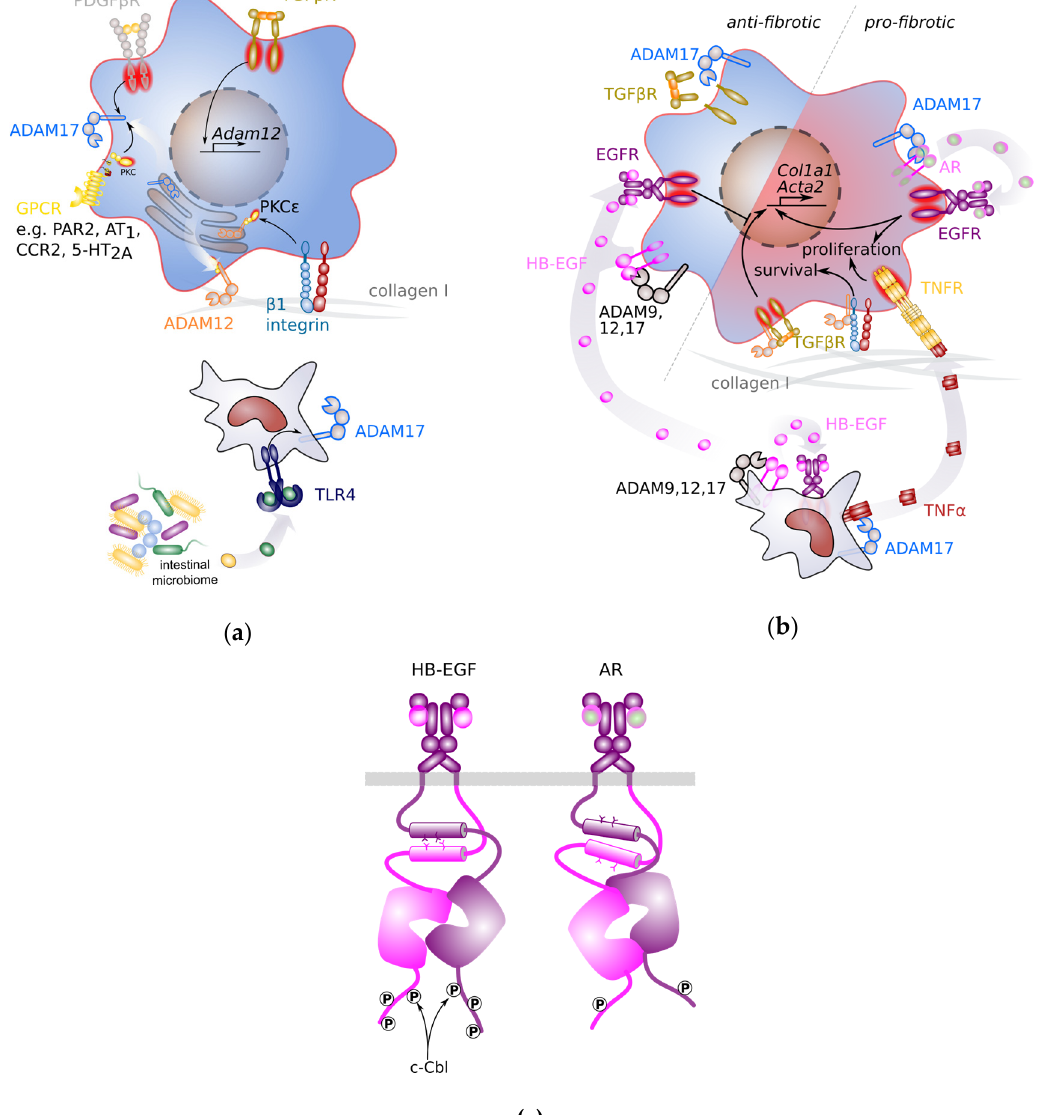
Figure 2. Major a disintegrin and metalloprotease (ADAM)-associated fibrotic pathways. ( a ) Molecular pathways leading to expression and activation of ADAM proteases in hepatic stellate cells (HSCs) or myeloid cells. ( b ) Pro- and anti-fibrotic pathways regulated by ADAM proteases. ( c ) Heparin-binding EGF-like growth factor (HB-EGF) and amphiregulin (AR) binding to epidermal growth factor receptor (EGFR) induces di ff erent EGFR conformers, resulting in the activation of di ff erent downstream signalling pathways such as recruitment of E3 ubiquitin-protein ligase Casitas B-lineage lymphoma (c-Cbl) in HB-EGF-stimulated but not AR-stimulated receptors. Schematic adapted from [78]. Di ff erential down-stream signalling of EGFR in HSCs might account for the di ff erence in fibrotic activity of AR and HB-EGF. ADAM: a disintegrin and metalloprotease; AR: amphiregulin; AT1: angiotensin II receptor 1; β 1 integrin; CCR2:; EGFR: epidermal growth factor receptor; GPCR: G-protein coupled receptor; 5-HT2A: 5-hydroxytryptamin receptor 2A; HB-EGF: heparin-binding epidermal growth factor; PAR2: proteinase activated receptor 2; PDGF β R: platelet-derived growth factor β receptor; PKC: protein kinase C; TGF β R: transforming growth factor β receptor; TLR4: toll-like receptor 4; TNF α : tumour necrosis factor α ; TNFR: TNF receptor.